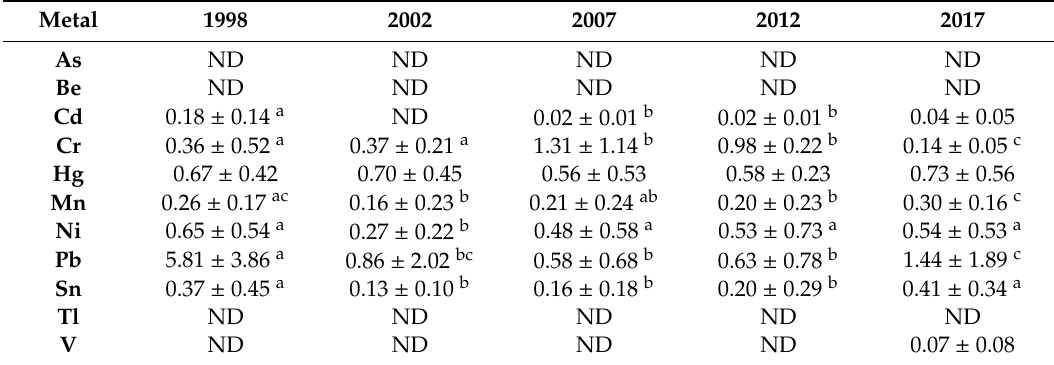
Table 4. Metal concentrations ( µ g / g) in hair of school children living in Tarragona County obtained